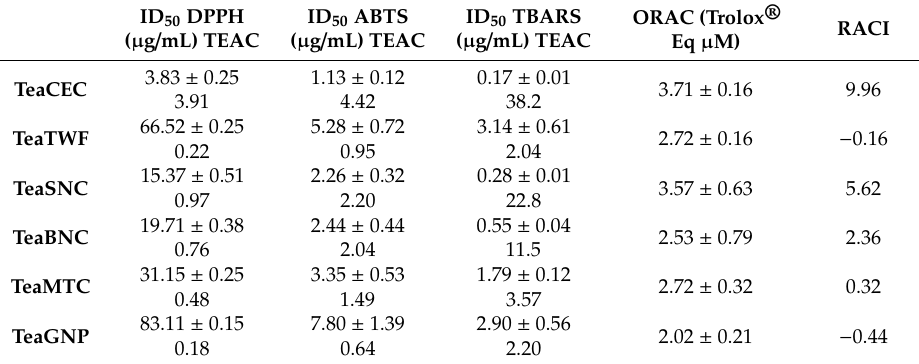
Table 4. Antioxidant activity of green tea extracts expressed as ID 50 ( µ g / mL) and TEAC (Trolox